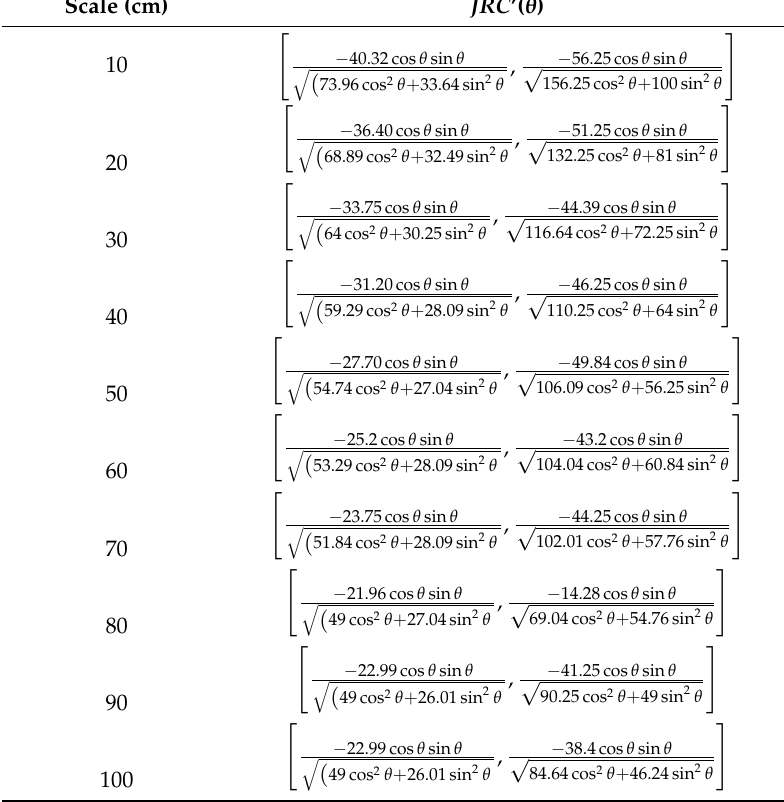
Table 2. NN functions of JRC ’( θ ) of different sized joint samples and I (cid:15) [0, 0.5]. Scale